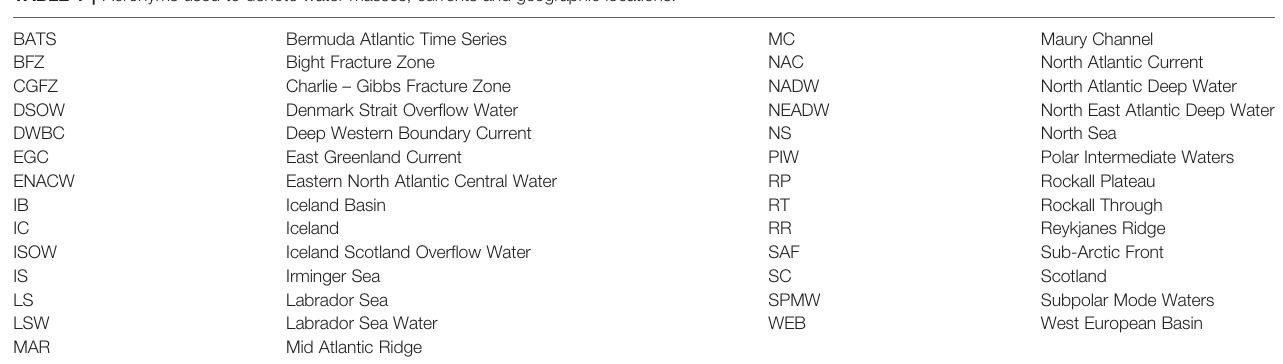
TABLE 1 | Acronyms used to denote water masses, currents and geographic